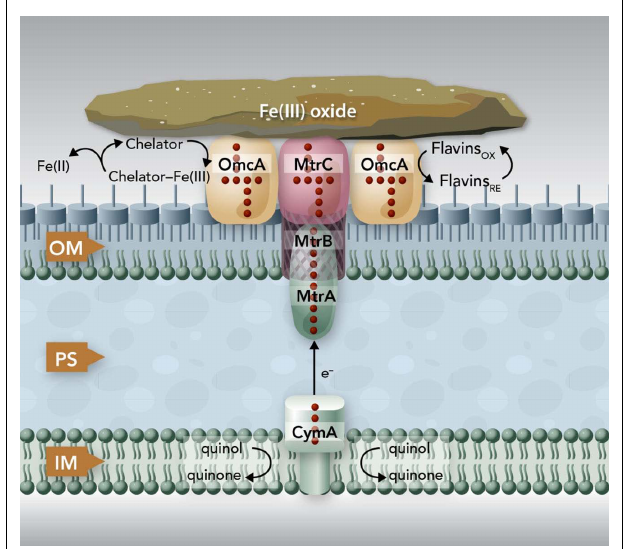
FIGURE 3 |The proposed Mtr extracellular electron transfer pathway of S. oneidensis MR-1. The protein components identified to date for the Mtr pathway include CymA, MtrA, MtrB, MtrC, and OmcA. CymA is a tetraheme c -Cyt that belongs to the NapC/NrfH family of quinol dehydrogenases. Through its N-terminal region, CymA is anchored in the inner-membrane (IM) where it oxidizes quinol in the IM and transfers the released electrons to MtrA in the outer-membrane (OM) either directly or indirectly via other periplasmic proteins. MtrA is a decaheme c -Cyt that is thought to be embedded in MtrB, a trans OM, and porin-like protein.Together, MtrAB facilitate the electron transfer across the OM to the MtrC and OmcA on the bacterial surface. Both MtrC and OmcA are the OM decaheme c -Cyts that are translocated across the OM by the bacterial type II secretion system. MtrC and OmcA are the terminal reductases that bind the surface of Fe(III) oxides and transfer electrons directly to the oxides via their solvent-exposed hemes.To increase their reaction rates, MtrC and OmcA use flavins secreted by the S. oneidensis MR-1 cells as diffusible co-factors or shuttles for Fe(III) oxide reductions. MtrC and OmcA can also serve as the terminal reductases for the Fe(III) solubilized from the Fe(III) oxides by the Fe(III)-complexing ligands secreted from the S. oneidensis MR-1 cells. The sizes of the components depicted are not drawn to the